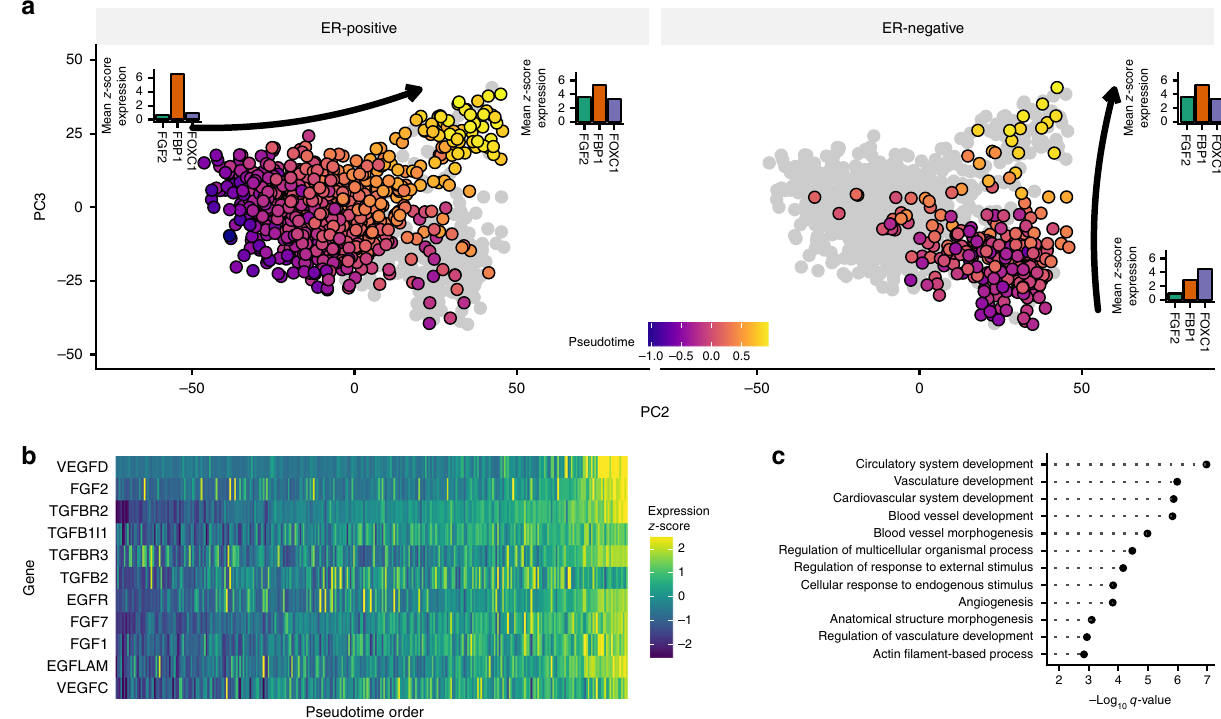
Fig. 6 Vascular growth trajectories uncovered by PhenoPath in breast cancer. a Principal components visualisation of ER − dependent pseudotemporal trajectories. b Expression of a number of vascular growth markers shows upregulation over the inferred pseudotime trajectory. c A GO enrichment analysis of upregulated genes con fi rms the latent trajectory encodes angiogenesis pathway activation in each